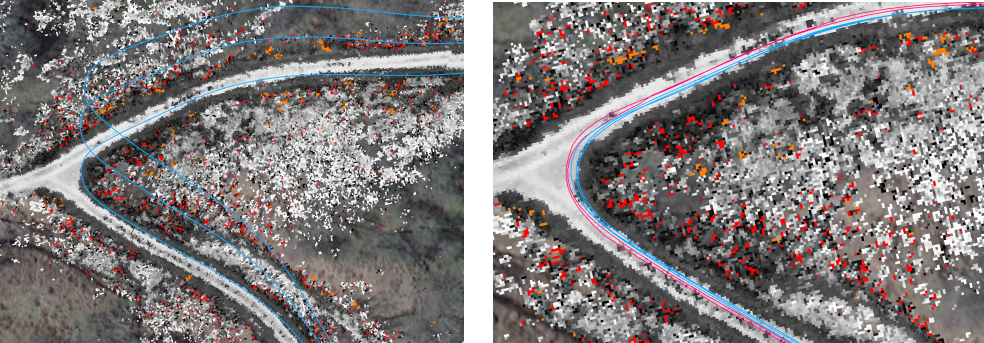
Figure 8. The same manually driven path is analyzed with and without reference to the persistent map. On the left, the vehicle’s state estimate, shown in blue, exhibits the expected odometric drift across repeated traversals of the same trail. On the right, costmap based localization, shown in red, prevents the vehicle’s state estimate, shown in blue, from drifting without GPS.